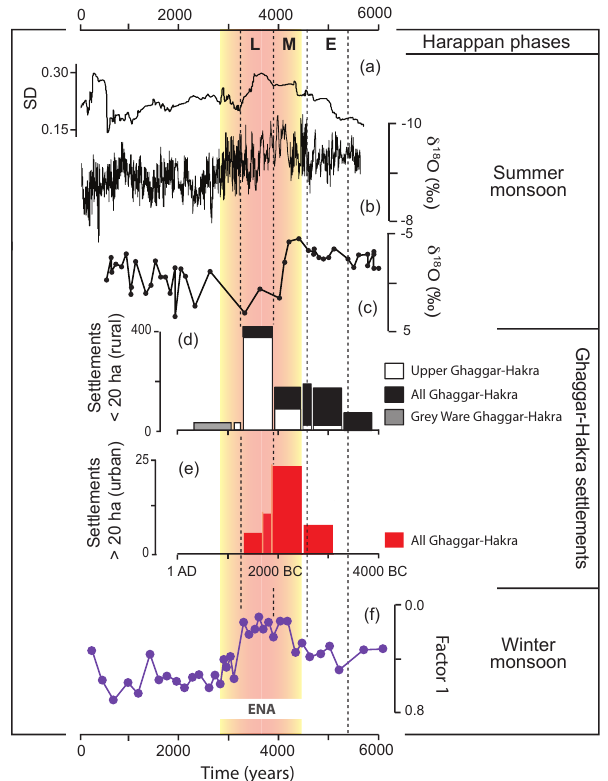
Figure 6. Monsoon hydroclimate changes since the middle Holocene and changes in settlement distribution on the Ghaggar- Hakra interfluve. From high to low ( a – f ): (a) variability in summer monsoon calculated as 200-year window moving standard devia- tion of the detrended monsoon record of Katahayat et al. (2017) and (b) the speleothem δ 18 O-based summer monsoon reconstruc- tion of Katahayat et al. (2017); (c) lacustrine gastropod δ 18 O-based summer monsoon reconstruction (Dixit et al., 2014); (d, e) changes in the number of settlements on the Ghaggar-Hakra interfluve as a function of size and location; and (f) winter monsoon ancient DNA- based reconstruction for the northeastern Arabian Sea (this study – in purple). The period corresponding to the early neoglacial anoma- lies (ENA) is shaded in red hues and durations for Early (E), Mature (M) and Late (L) Harappan phases are shown with dashed